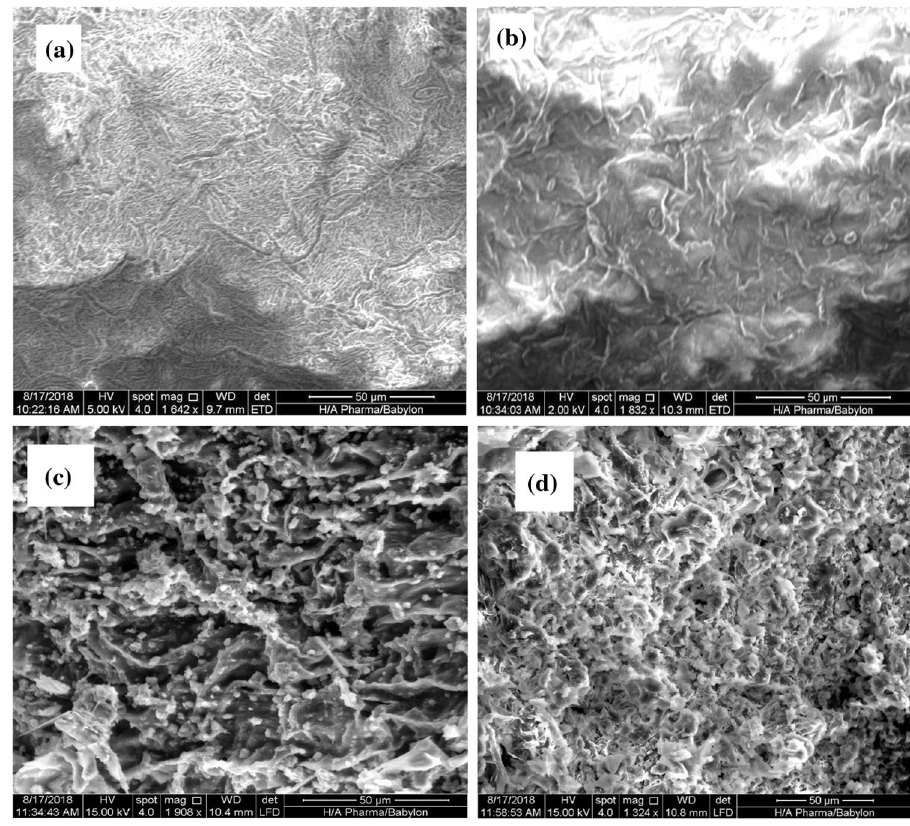
Fig. 6 SEM test results for natu- ral RC adsorbent ( a : before, b : after) adsorption and activated RC adsorbent( c : before, d : after)